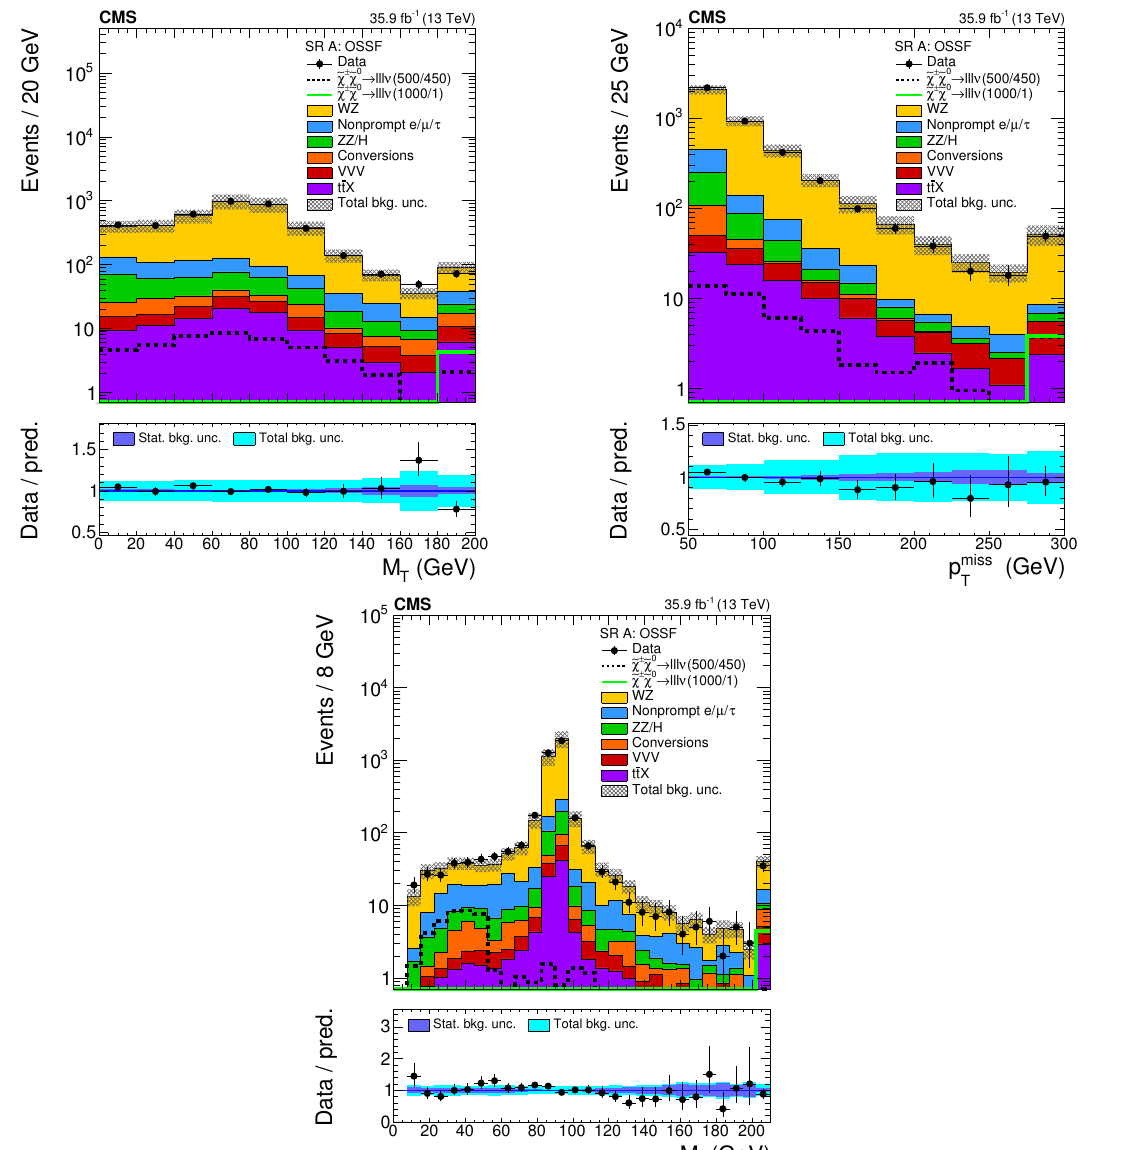
Figure 5 . Distribution of kinematical observables used in the event selection for events entering signal regions A: the transverse mass of the third lepton (upper left), the p miss the M ‘‘ of the OSSF pair (lower). Two signal mass points in the (cid:13)avor-democratic model with mass parameter x = 0 : 5 are displayed for illustration. The notation is analogous to that used in (cid:12)gure 4.